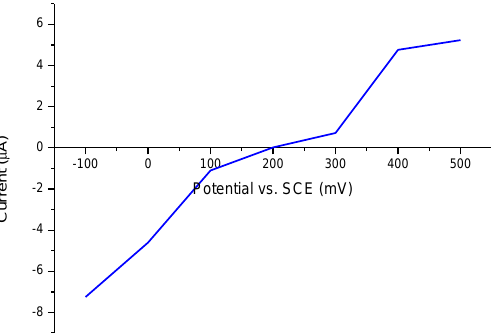
Figure 8. Steady-state response of biosensor in presence of xanthine 0.2 mM in an oxygen satu- rated (24 °C) phosphate buffer (pH = 7.0)/NaClO 4 (0.1 m) solution at several potential values. RDE